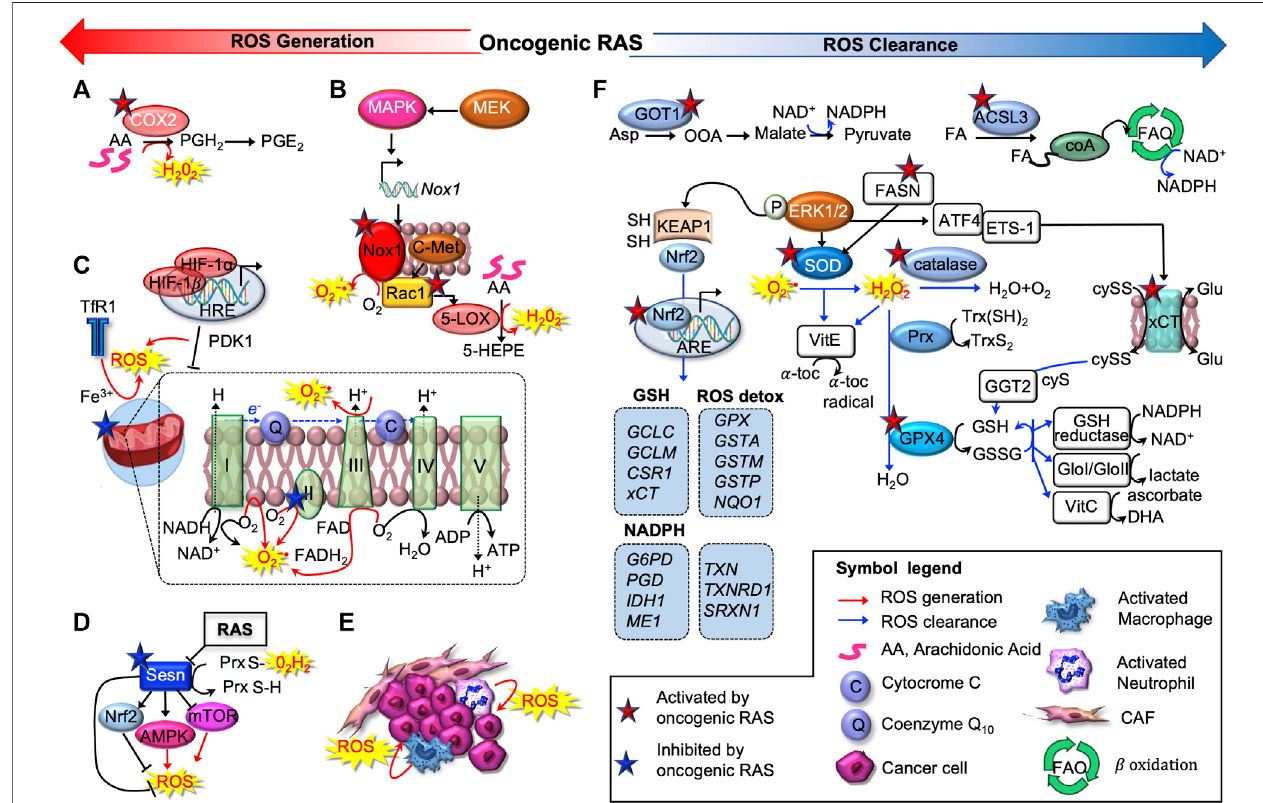
FIGURE2| OncogenicRASinducespro-oxidantandanti-oxidantprograms.OncogenicRASpromotesROSproductionexploitingseveralstrategies,asactivation of cyclooxygenase-2 (COX2) (A) , subunits of the NADPH oxidase complex (NOX1/4) (B) , regulating mitochondrial activity (C) or inactivating sestrin 1 (SESN1) (D) . The tumor microenvironment (TME) can also produce ROS, contributing to maintain oxidative, pro-tumorigenic conditions (E) . Oncogenic RAS drives multiple antioxidant programs as well (F) . First, it can upregulate the main antioxidant enzymes superoxide dismutases (SOD); catalase and peroxidases, of which GPX4 is the main member. Oncogenic RAS can drive NADPH production through an alternative glutamine metabolic pathway mediated by aspartate aminotransferase (GOT1), or potentially via a fatty acid oxidation pathway mediated by acyl-coenzyme A (CoA) synthetase long-chain family member 3 (ACSL3). In addition, oncogenic RAS upregulates several key antioxidant proteins, including the light-chain subunit of the system xc − transporter (xCT), nuclear factor, erythroid 2-like 2 (NRF2), and gamma- glutamyltransferase 2 (GGT2).